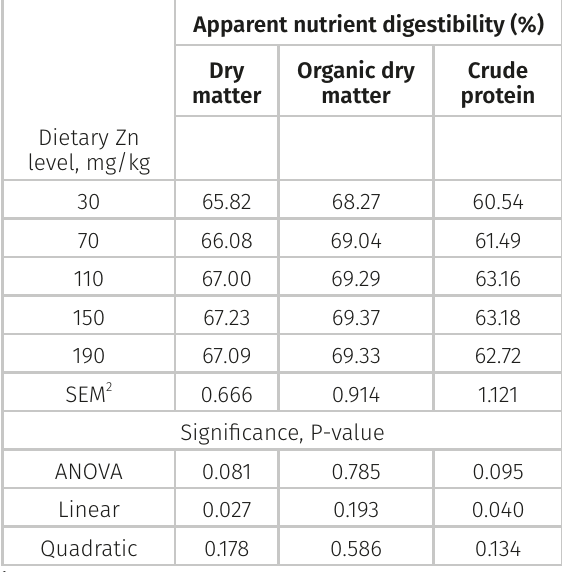
Table IV. Effect of dietary Zn concentration on apparent dry matter, organic dry matter and crude protein digestibility in broiler chickens fed wheat-soy diets 1